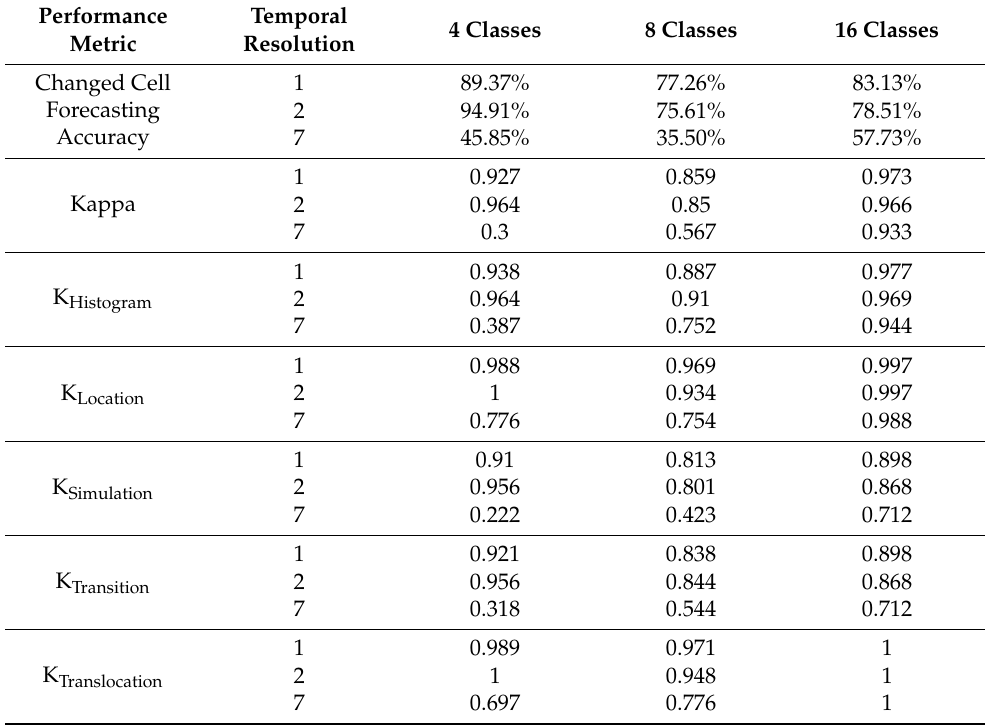
Table 8. Performance metrics obtained using Subset A of the hypothetical dataset (including timesteps 0 to 14), featuring 15-year LC datasets with 4, 8, and 16 classes.